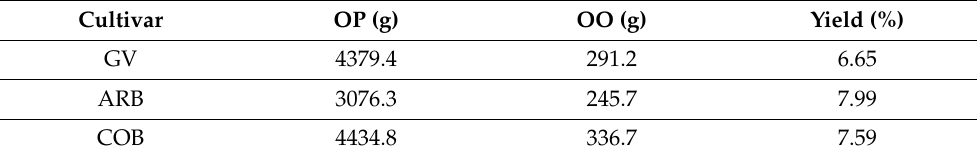
Table 2. Olive oil (OO) laboratory scale (LS) production yield for three olive cultivars: ‘Galega vulgar’ (GV), ‘Arbequina’ (ARB), ‘Cobrançosa’ (COB), with reference to the produced olive paste (OP). Cultivar OP (g) OO (g) Yield (%) GV 4379.4 ARB 3076.3 245.7 COB 4434.8 336.7